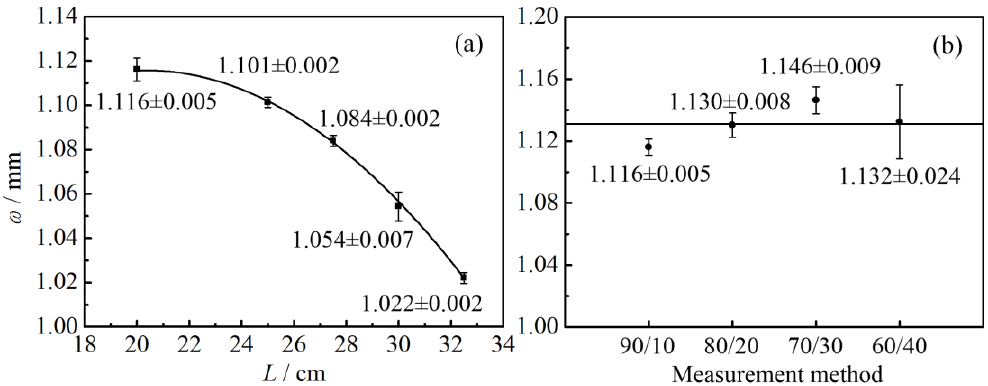
Figure 3. Measurement results of laser radius. ( a ) Laser radius in different locations; ( b ) laser radius measured by different methods.